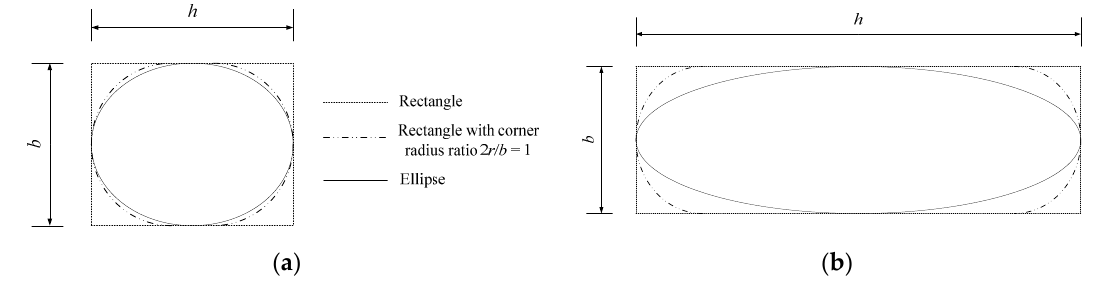
Figure 8. Cross-sectional unification. In Equation (7) and Figure 3, E 2 is the slope of the asymptotic line of the hardening curve in the stress-strain relationship of concrete highly confined by FRP. According to its definition and conclusions in the existing investigations [14,19,28], the function of E 2 uses the following equation. 2